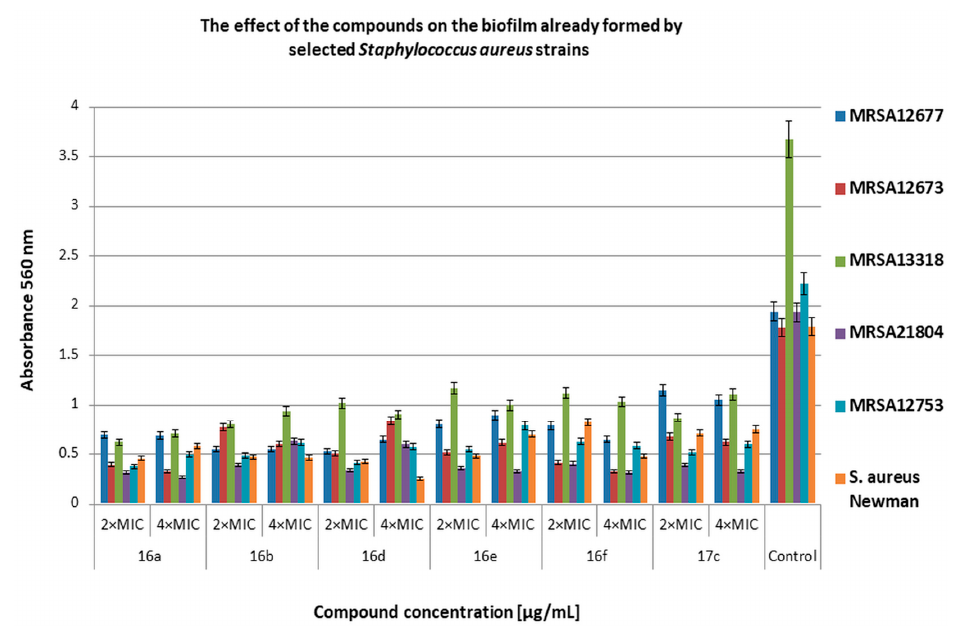
Figure 6. The effect of the selected compounds on 24 h biofilm already formed by methicillin-resistant S. aureus (MRSA) strains. Bacteria without compounds were a control group. Double the minimum inhibitory concentration—2 × MIC, quadruple the minimum inhibitory concentration—4 × MIC. The results are presented as mean values ± standard deviation (±SD) from three independent experiments. Error bars represent standard deviation.